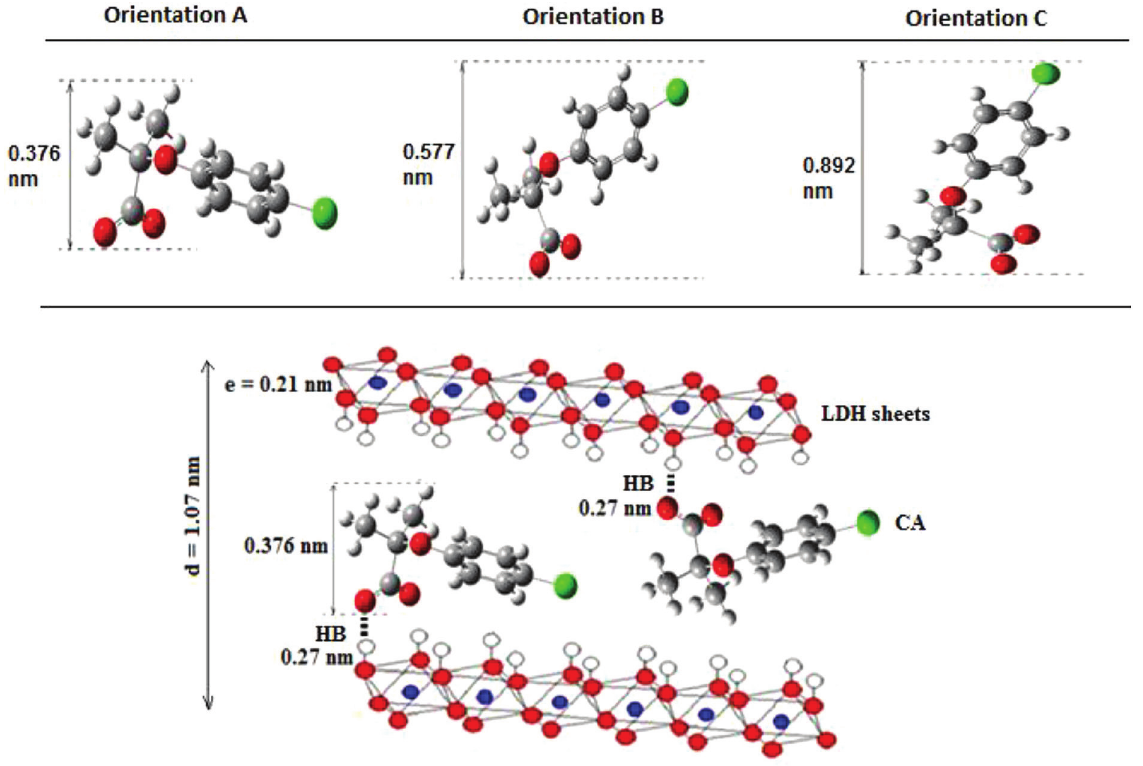
Fig. 12 – Structural model of CA orientation between LDH